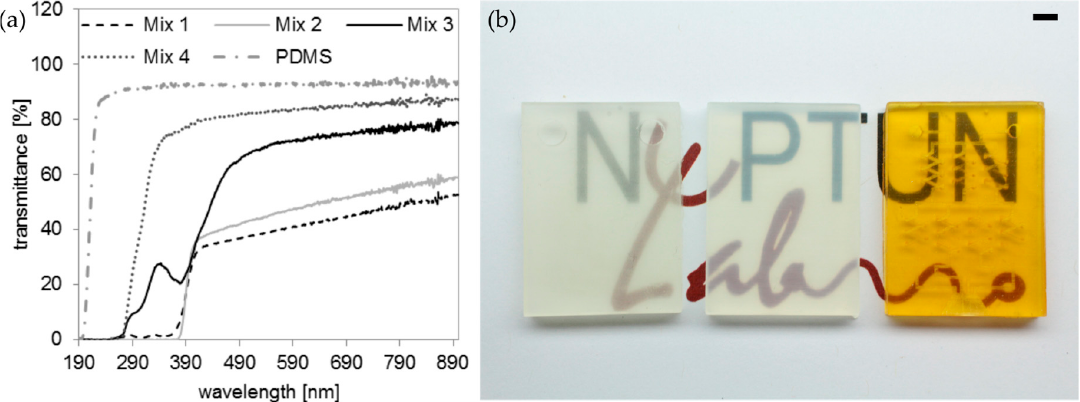
Figure 8. UV-Vis spectroscopy of PDMS and the printed PFPE methacrylates from mix 1, 2, 3 and 4 show different transparencies between 190–900 nm: ( a ) Transmission spectra of polymerized PDMS and PFPE methacrylates from mixtures 1, 2, 3 and 4 (thickness: 250 µm). Mix 1 shows a transparency of about 30% between 400–900 nm, mix 2 a transparency above 35% between 400–900 nm and mix 3 has a transmission above 70% between 520–900 nm. Mix 4 has a transparency of over 75% between 350–900 nm. Peaks at 330 and 280 nm are measured for the formulations prepared with TPO as photoinitiator. For comparison the UV-Vis spectrum of PDMS is shown; ( b ) Three microfluidic chips printed from mixtures 1, 2, and 3 (from left to right) show different transparencies as a function of the used absorber (scale bar: 4 mm).